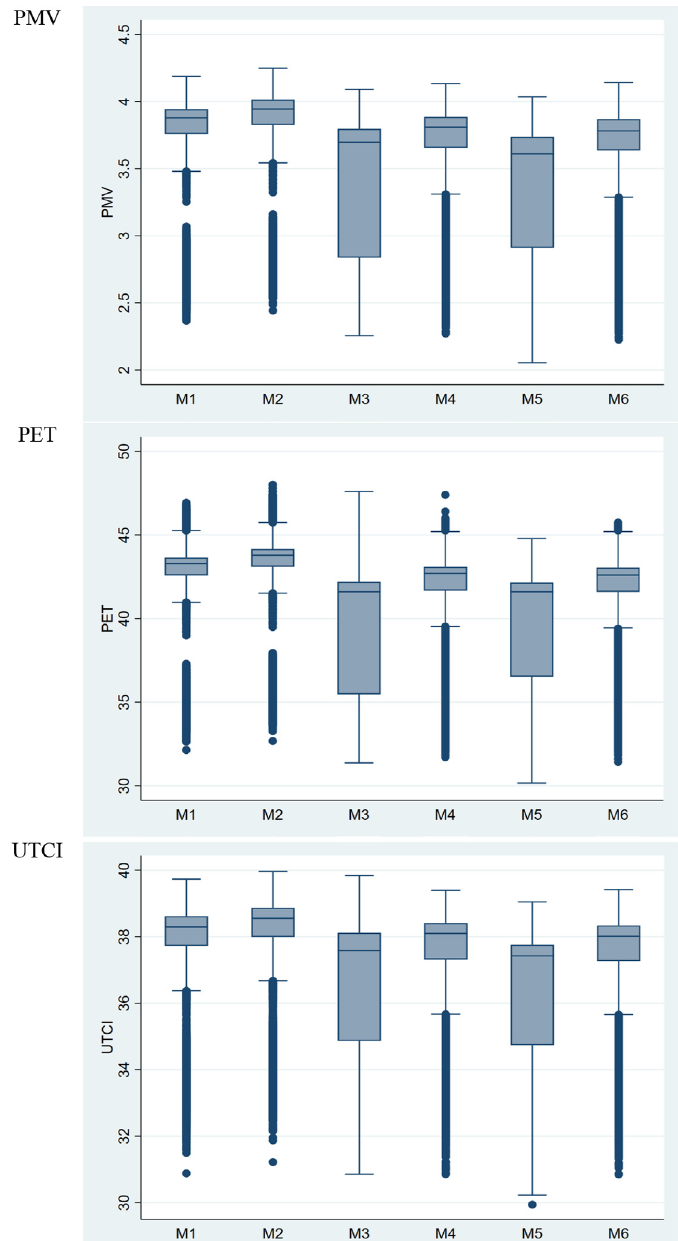
Figure 6. Simulation results of PMV, PET and UTCI under normal heat